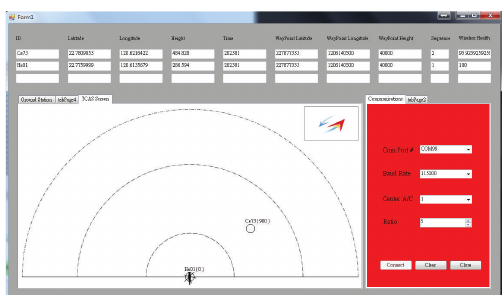
Figure 13: Display of intrusion on the manned helicopter when RA is